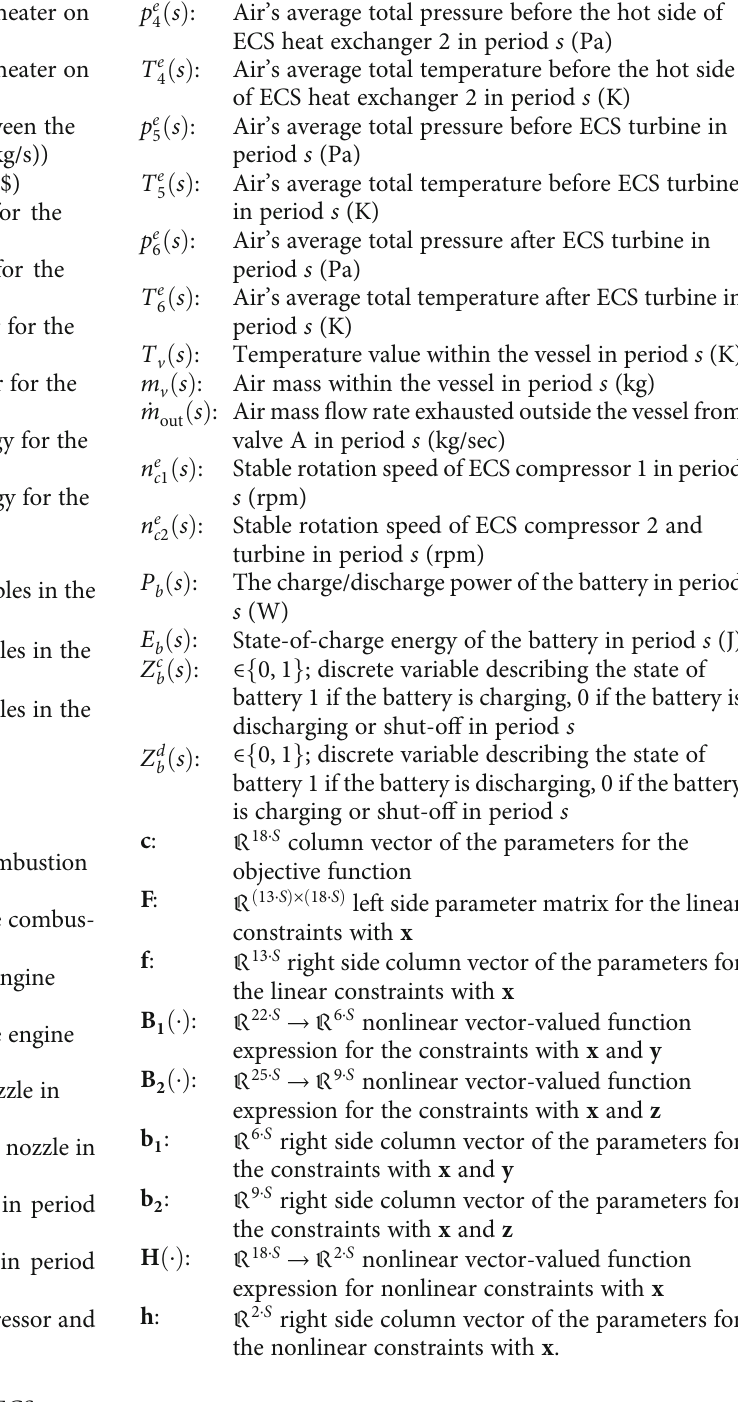
expression for nonlinear constraints with x h ℜ 2 ⋅ S right side column vector of the parameters for the nonlinear constraints with x